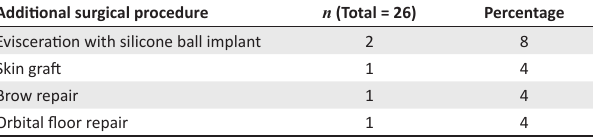
TABLE 4: Additional surgical procedures performed.